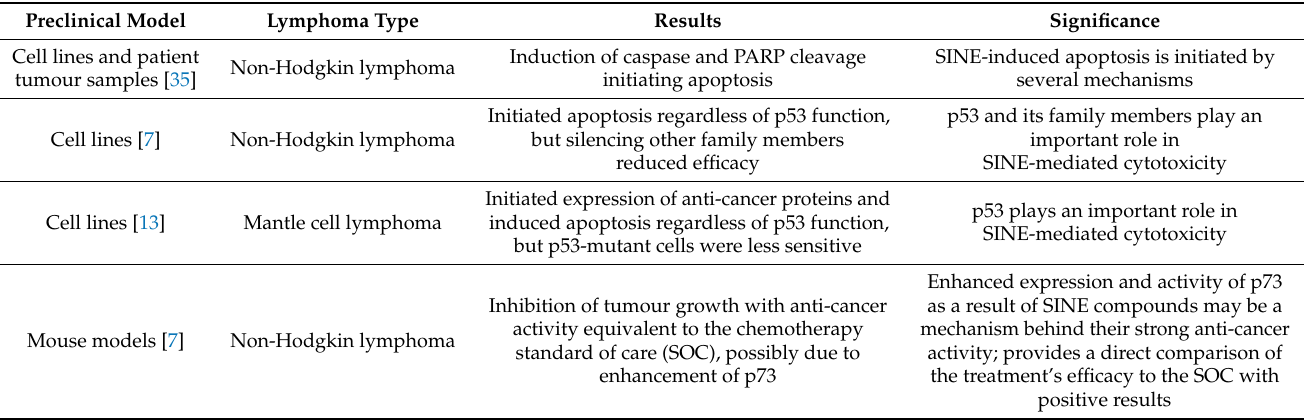
Table 2. Preclinical Data Investigating Selinexor and its Related Compounds as Monotherapies for Non-Hodgkin